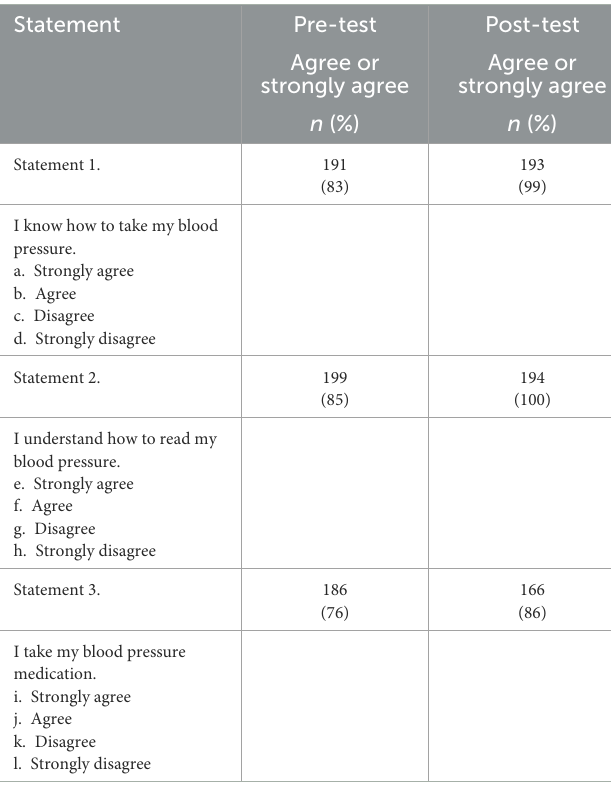
TABLE 3 Pre-test/post-test confidence in hypertension management